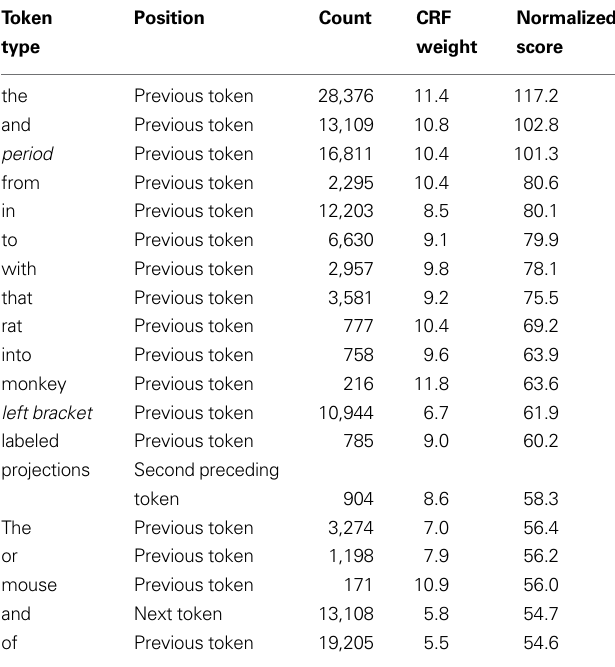
Table 3 | Top 20 context features from text only